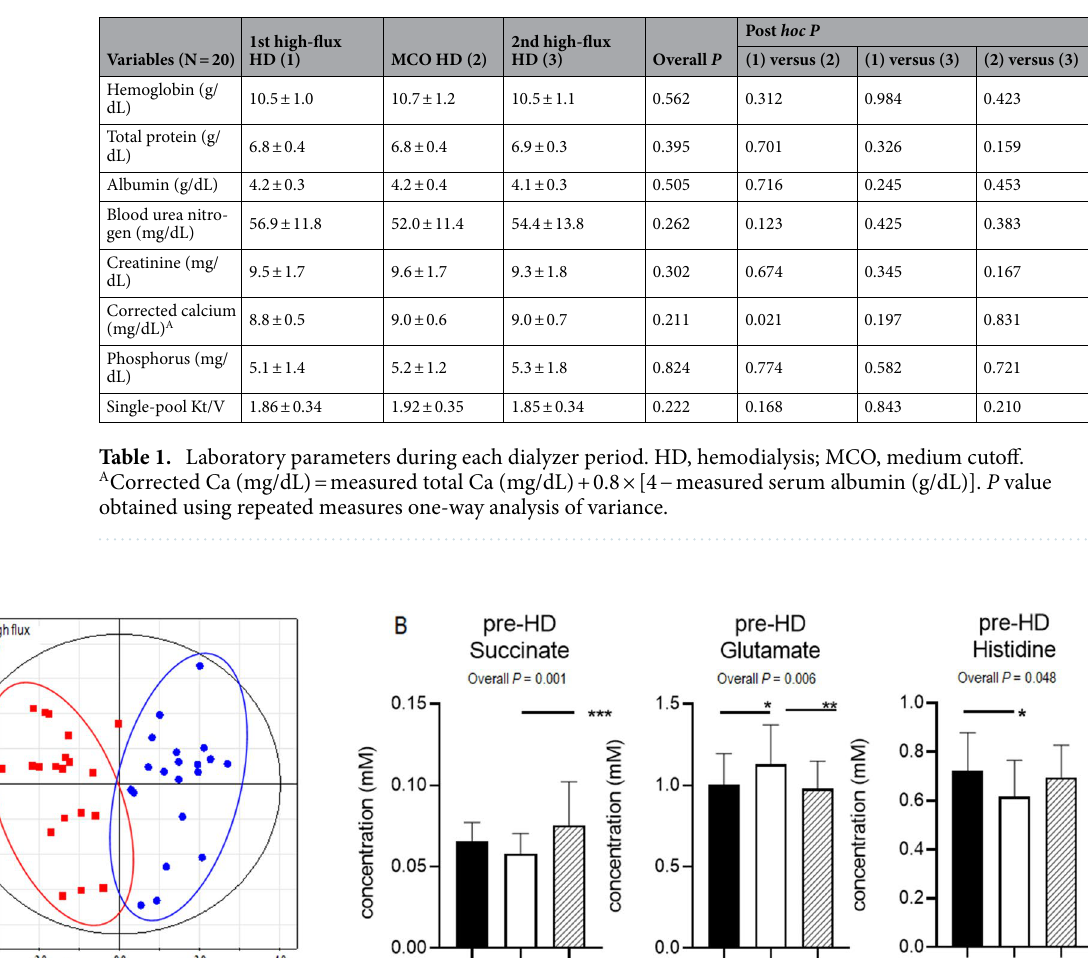
glutamate, alanine, trimethylamine N-oxide, methionine, threonine, myo-Inositol, isobutyrate, and dimeth- ylamine, with VIP scores ≥ 1.0, were considered significant metabolites in the separation between the 1st HF and MCO pre-HD serum samples (Table 2). The Pre-HD concentrations of metabolites with a VIP score ≥ 1.0 between the 1st HF and MCO dialyzer samples are shown in Supplemental Fig. 1. We also analyzed the VIP scores of metabolites between MCO and 2nd HF dialyzer samples. Serine, succinate, glutamate, myo-Inositol, histidine, asparagine, isoleucine, betaine, 2-phenylpropionate, and glutamine, with VIP scores > 1.0, were con- sidered significant metabolites for the separation between MCO and 2nd HF pre-HD serum samples (Sup- plemental Table 2). The pre-HD concentrations of metabolites with a VIP score > 1.0 in both 1st HF versus MCO and MCO versus 2nd HF dialyzer comparisons and significantly different concentrations in the MCO period compared to the HF period are depicted in Fig. 2B. Pre-HD succinate ( p = 0.001) and histidine ( p = 0.048) were significantly decreased and those of glutamate ( p = 0.006) were significantly increased in the MCO dialyzer